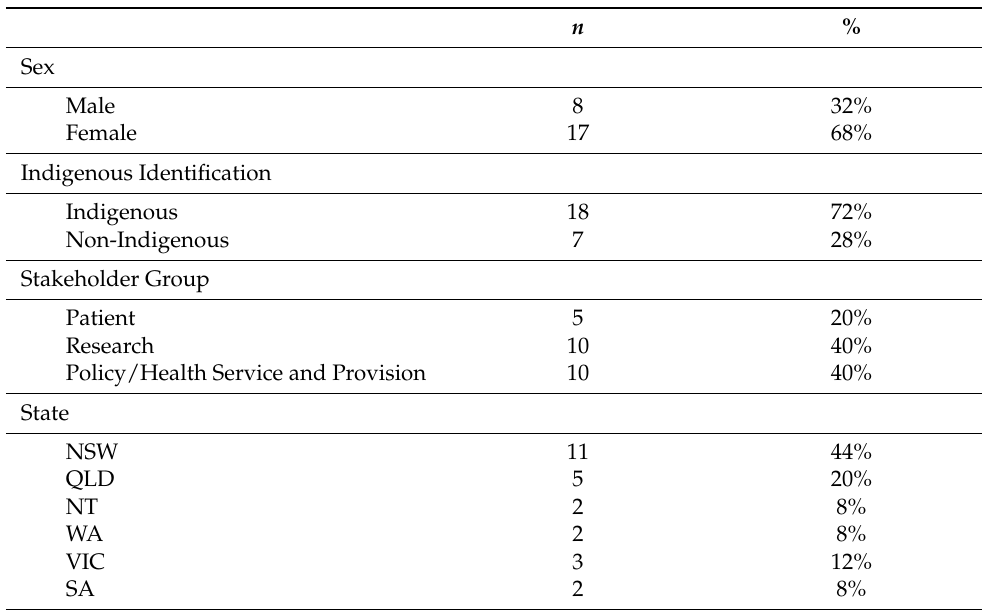
Table 1. Stakeholder Demographics ( n = 25 )